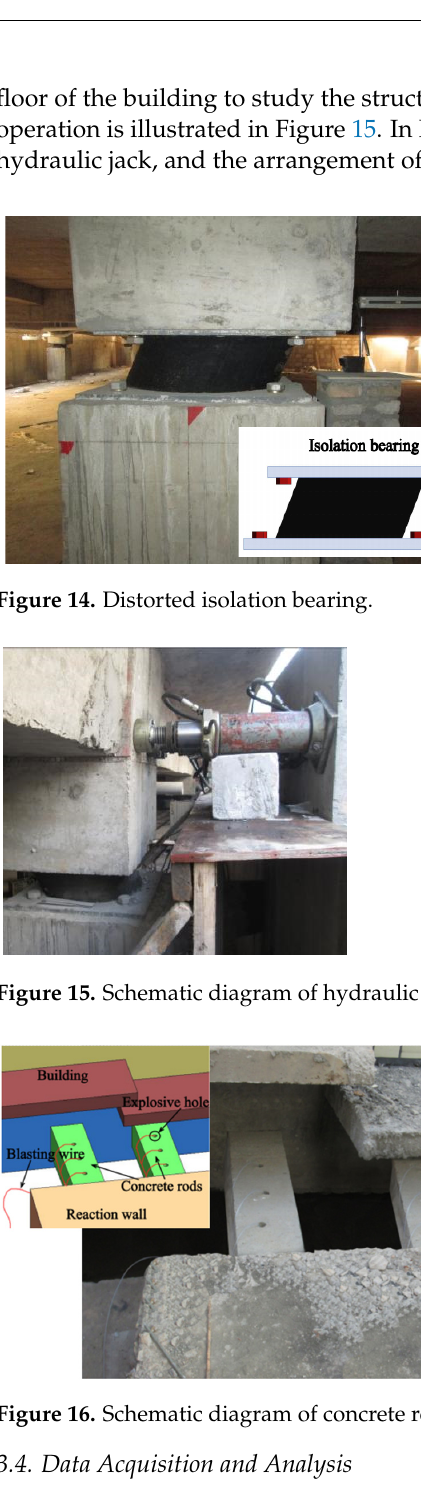
Figure 16. Schematic diagram of concrete rods.